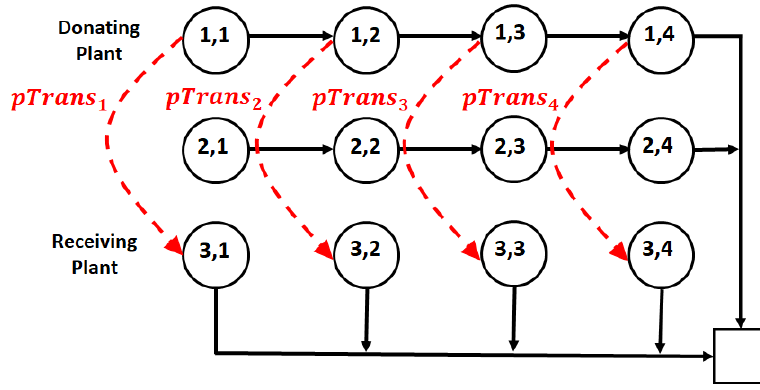
Figure 6. The transfer arc partition strategy